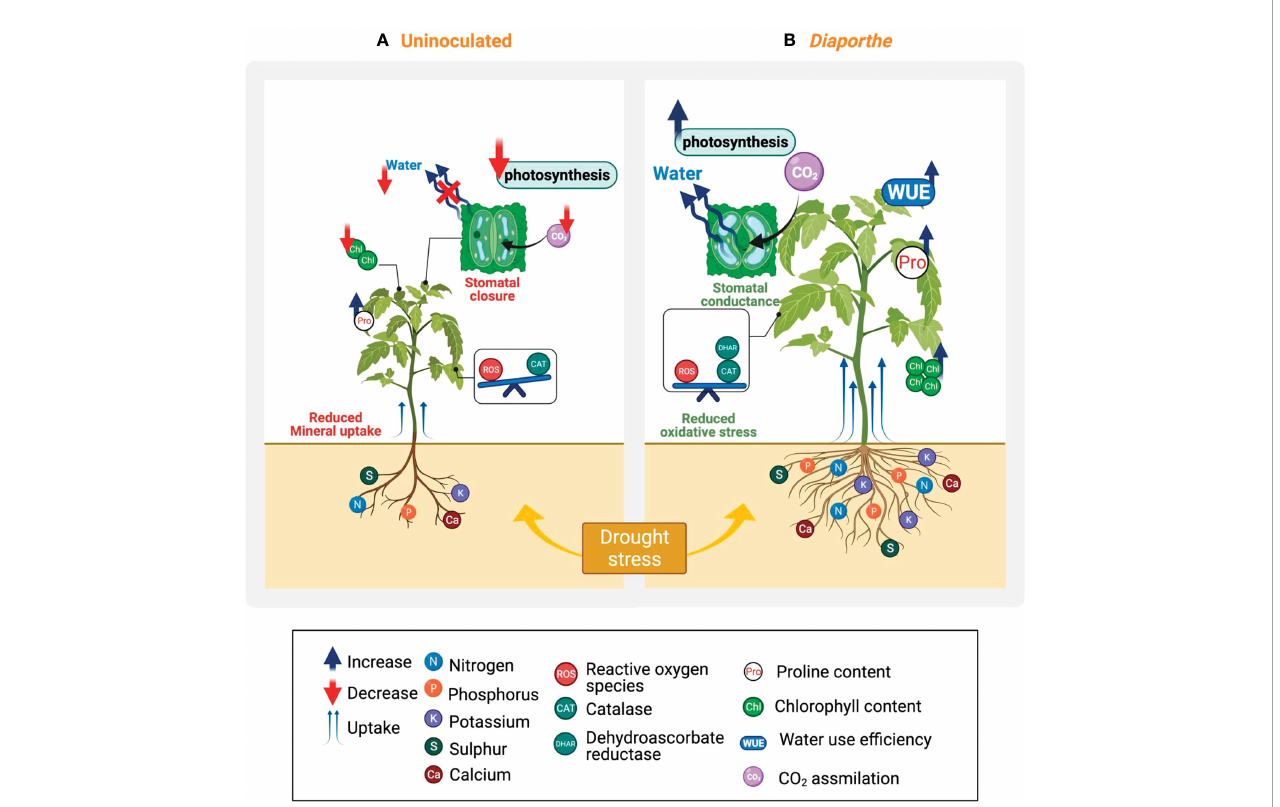
FIGURE 7 Overview of the effect of drought stress in uninoculated and Diaporthe -inoculated tomato plants. (A) Drought stress had a deleterious effect on tomato plant growth and biomass production. This biomass reduction can be associated with a reduction in photosynthetic activity caused by a reduction in stomatal conductance and consequently in the CO 2 assimilation rate, and also by a decline in the chlorophyll content. The stomatal closure decreased the water movement on the plant which can be also associated with a decrease in the mineral uptake. In response to drought stress, the activity of CAT and proline content increased to reduce oxidative damage and for an osmotic counterbalance, however, this increase does not seem to be enough to alleviate the negative effect. (B) Diaporthe signi fi cantly mitigated the harmful impact of drought stress through combined mechanisms, which include an increase in the chlorophyll content, an optimal stomatal conductance that facilitates the CO 2 assimilation, and a greater WUE, indicating the plant maintains its stomata open and subsequently preserves an optimal photosynthesis activity. Diaporthe stimulated the increase of antioxidant defense system, e.g., CAT and DHAR, suggesting a reduction of the oxidative stress caused by water limitations; signi fi cantly enhanced the proline content that can participate in the osmotic adjustment or in the structure protection, and increased the mineral uptake. All together favor plant growth under drought